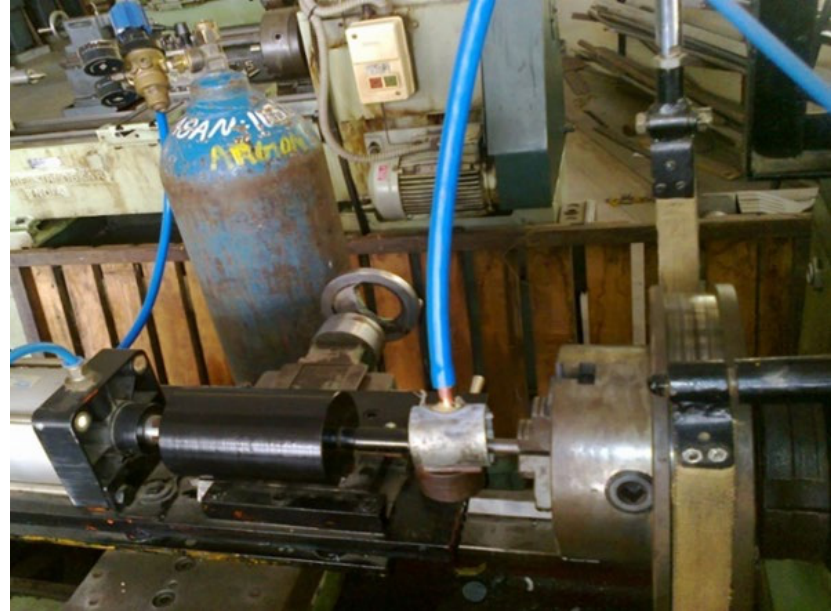
Figure 2. Experimental arrangement for friction stud welding in an inert gas atmosphere.